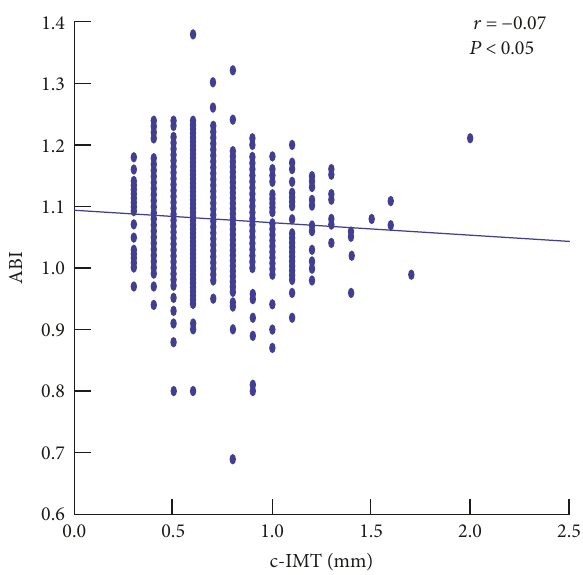
Figure 1: Correlation between the ankle-brachial index (ABI) and carotid intima-media thickness (c-IMT) in the